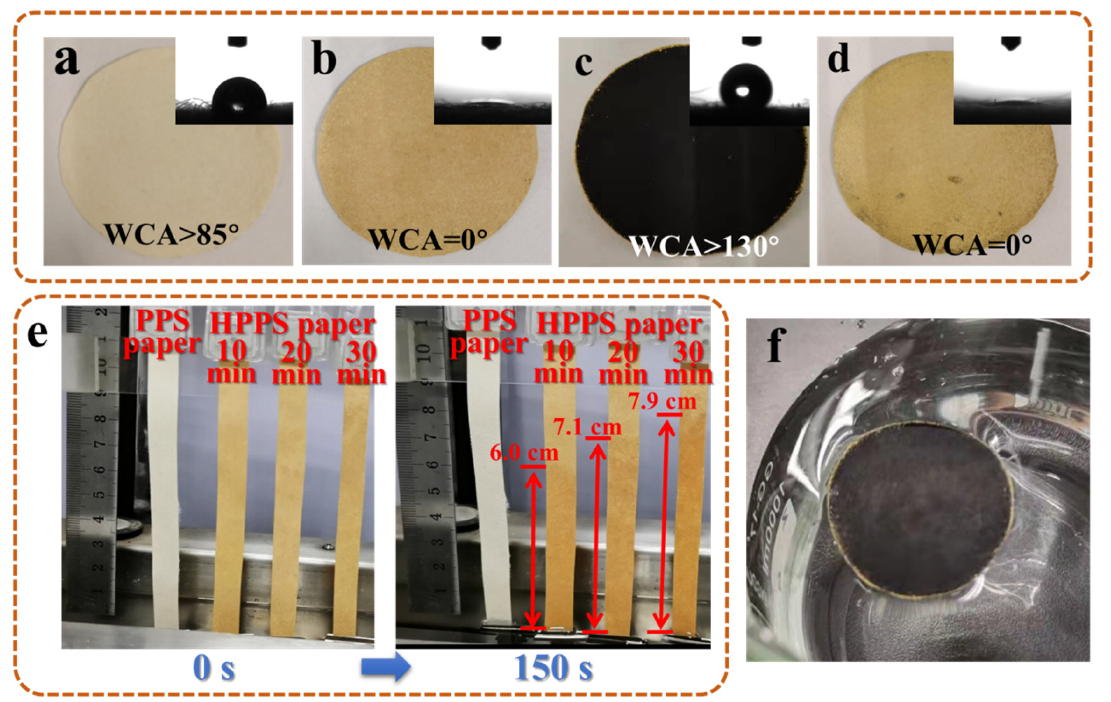
Figure 5. Digital images of prepared PPS paper ( a ), HPPS paper ( b ), and MWCNTs@HPPS paper: top ( c ) and bottom ( d ) surfaces, ( e ) wicking heights after 150 s, ( f ) self-floating ability of the MWCNTs@HPPS paper.